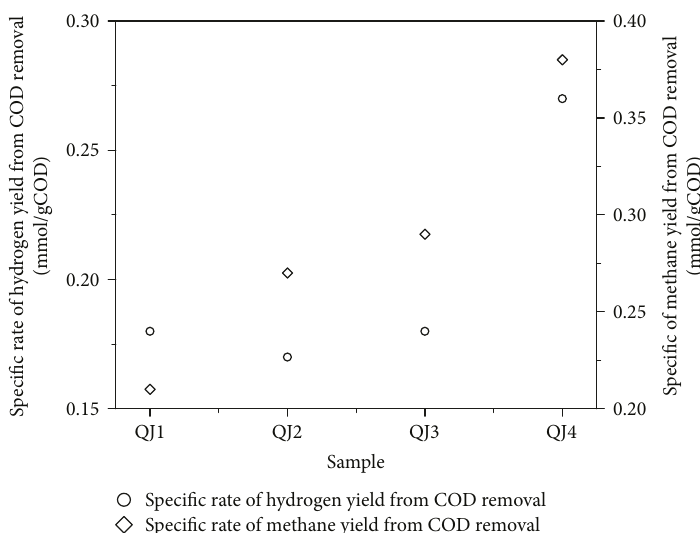
Figure 4: Speci fi c hydrogen and methane production ratio by COD